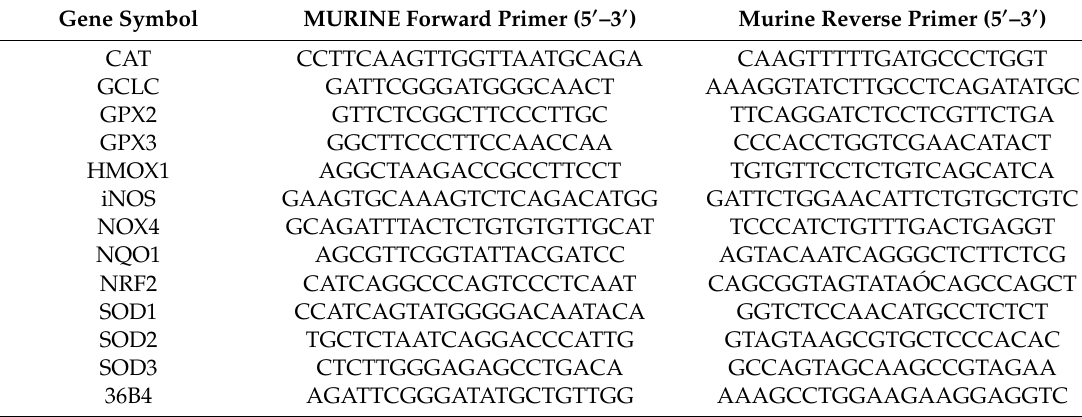
Table 1. Primers used in the RT-qPCR